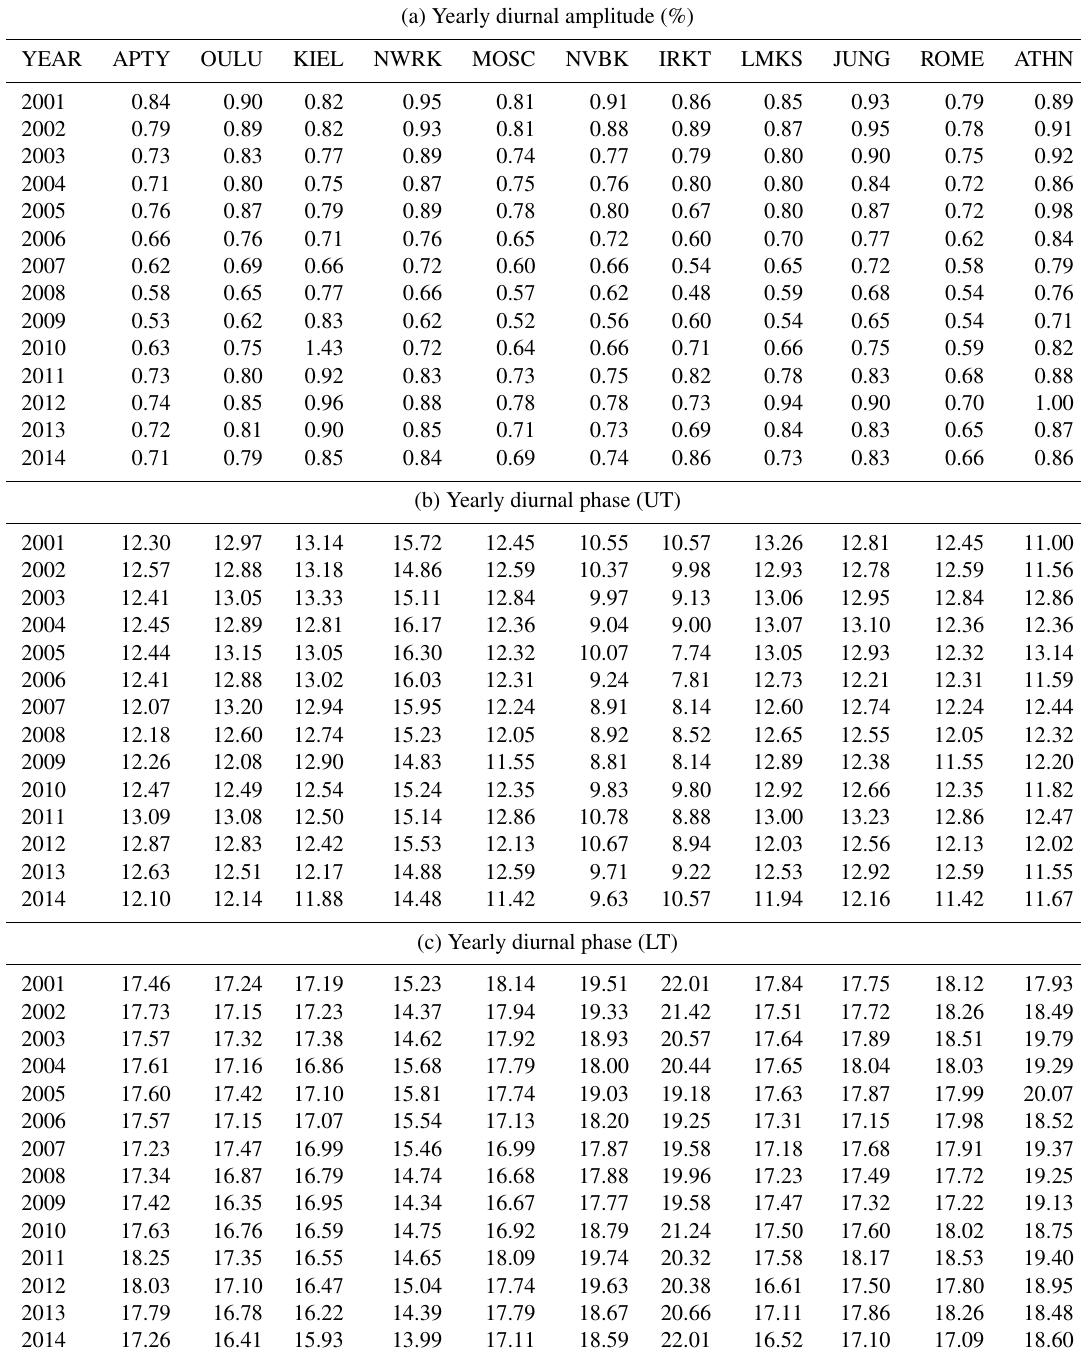
Table 2. Mean annual values of (a) the normalized diurnal amplitude, (b) the time of maximum in UT, and (c) the time of maximum in LT of cosmic ray intensity recorded at the selected NM stations for the time period